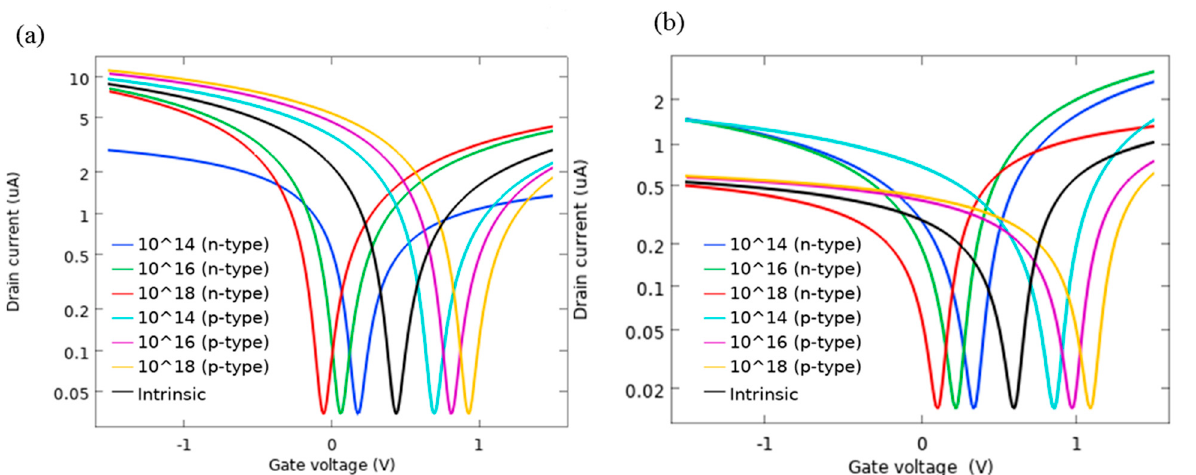
Figure 11. I–V characteristics as a function of doping type and concentration for ( a ) AlP-GFET, ( b ) Pd- GFET.